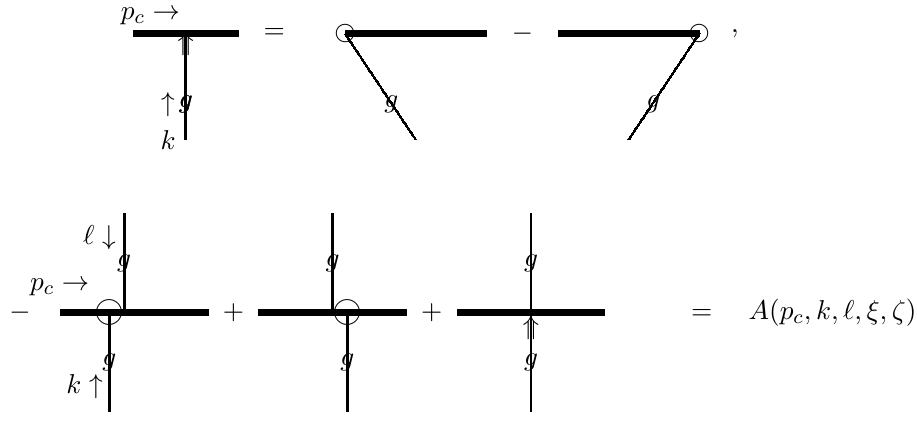
Figure 15 . Analog of (cid:12)gure 4 for gravity. The arrow on the graviton line represents that the polarization of the graviton carrying momentum k is taken to be equal to (cid:24) (cid:22) k (cid:23) + (cid:24) (cid:23) k (cid:22) . The polarization of the graviton carrying momentum k is taken to be (cid:16) (cid:26)(cid:27) . In the (cid:12)rst diagram the circle on the left denotes a vertex (cid:0) 2 (cid:24): ( p c + k ) while the circle on the right denotes a vertex (cid:0) 2 (cid:24):p c